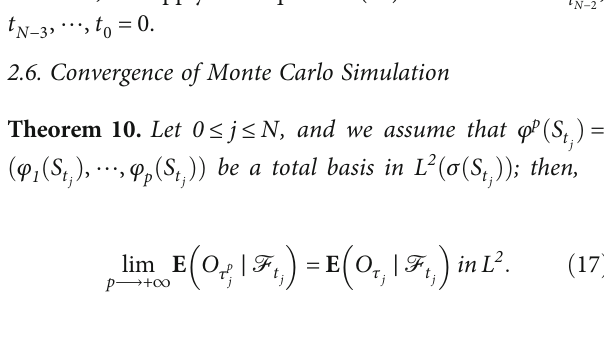
= 1 and λ = 1/4 1 2